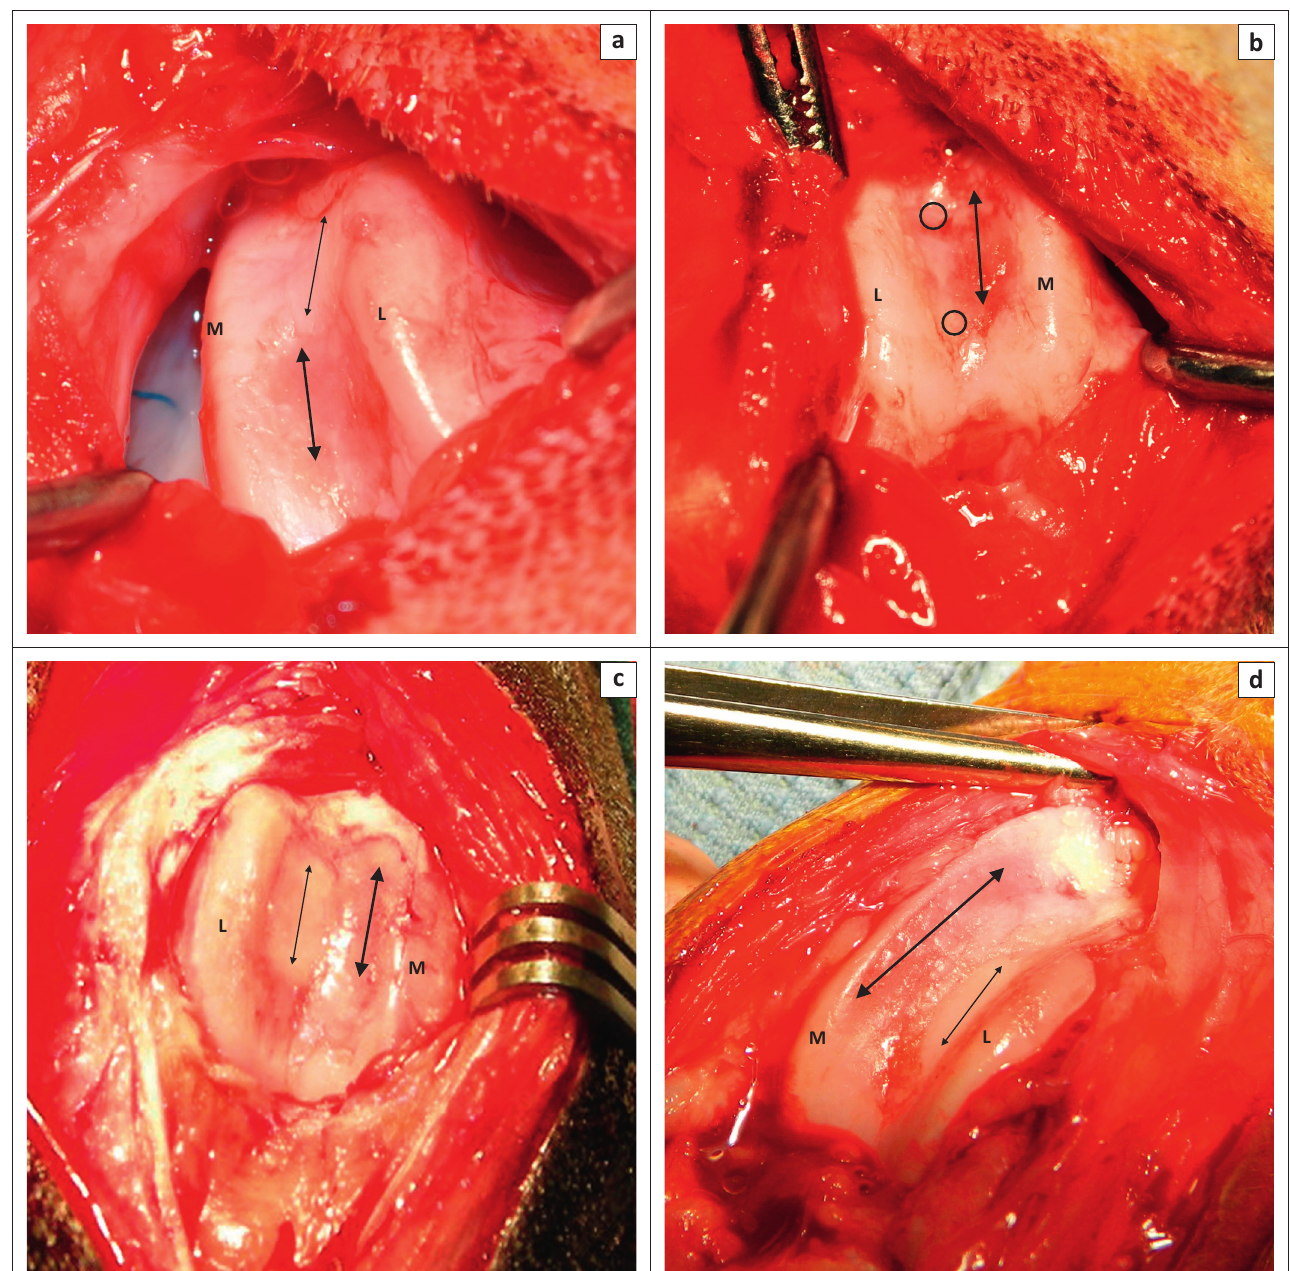
FIGURE 2: (a–d) Photographs of the four clinical